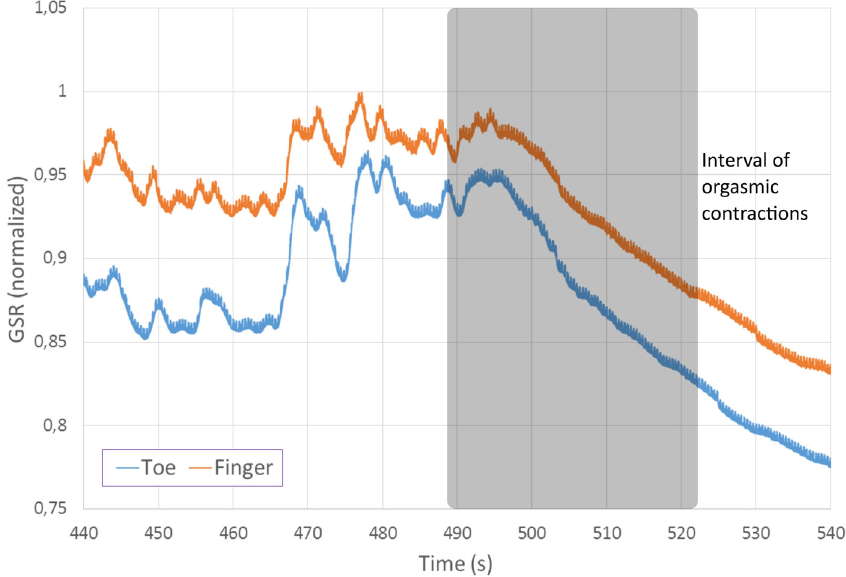
Figure 34: GSR recorded on toes and fi ngers during masturbation and